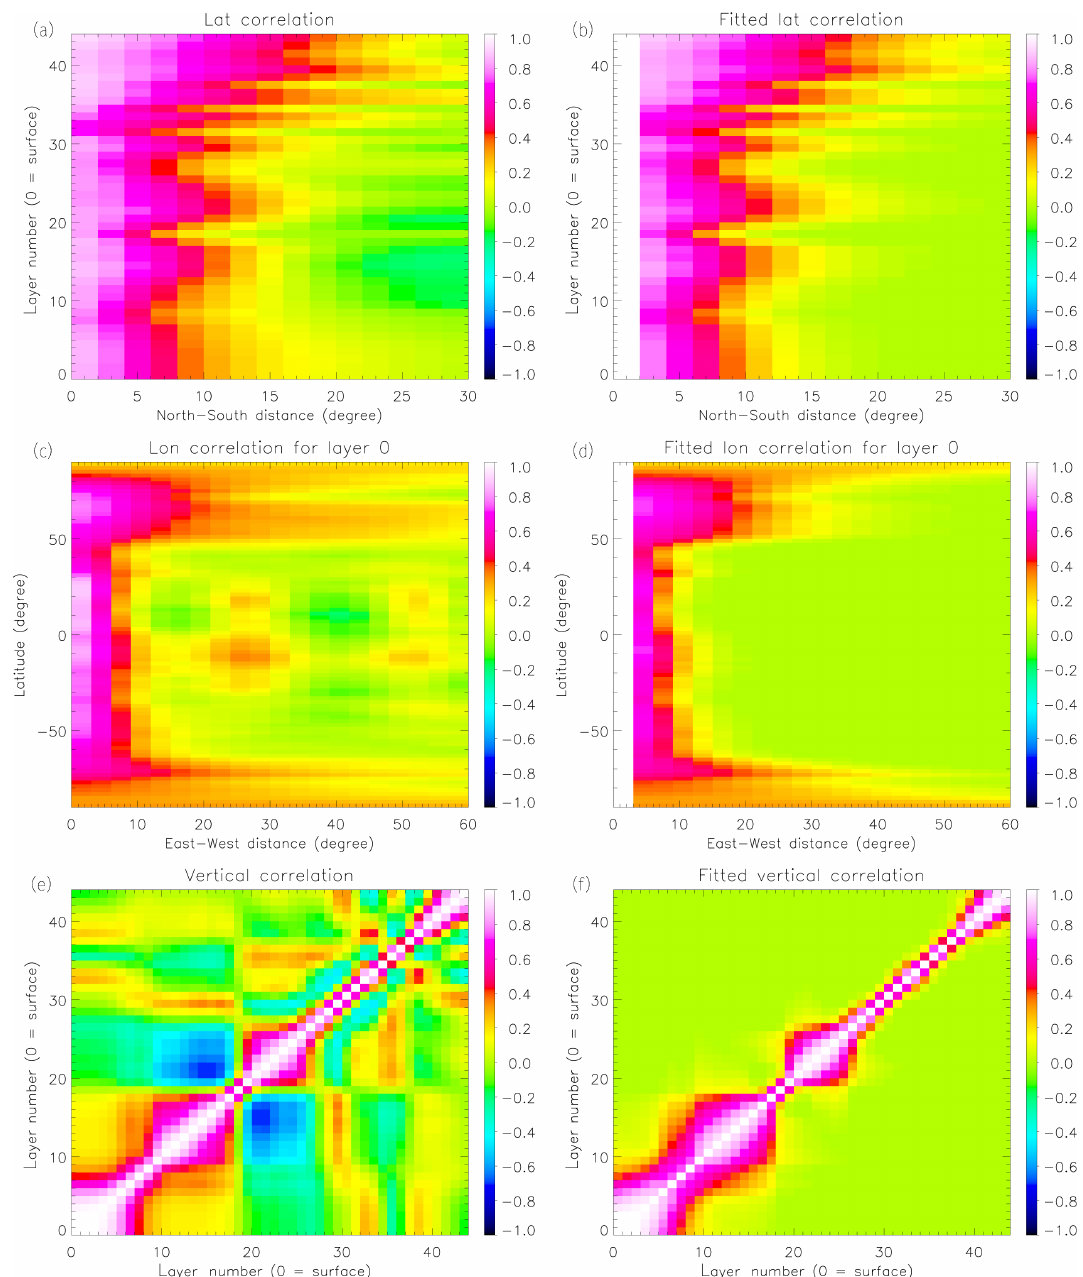
Figure 5. Calculated (a, c, e) and fitted (b, d, f) correlations for the latitudinal (a, b) , surface layer longitudinal (c, d) and vertical (e, f)